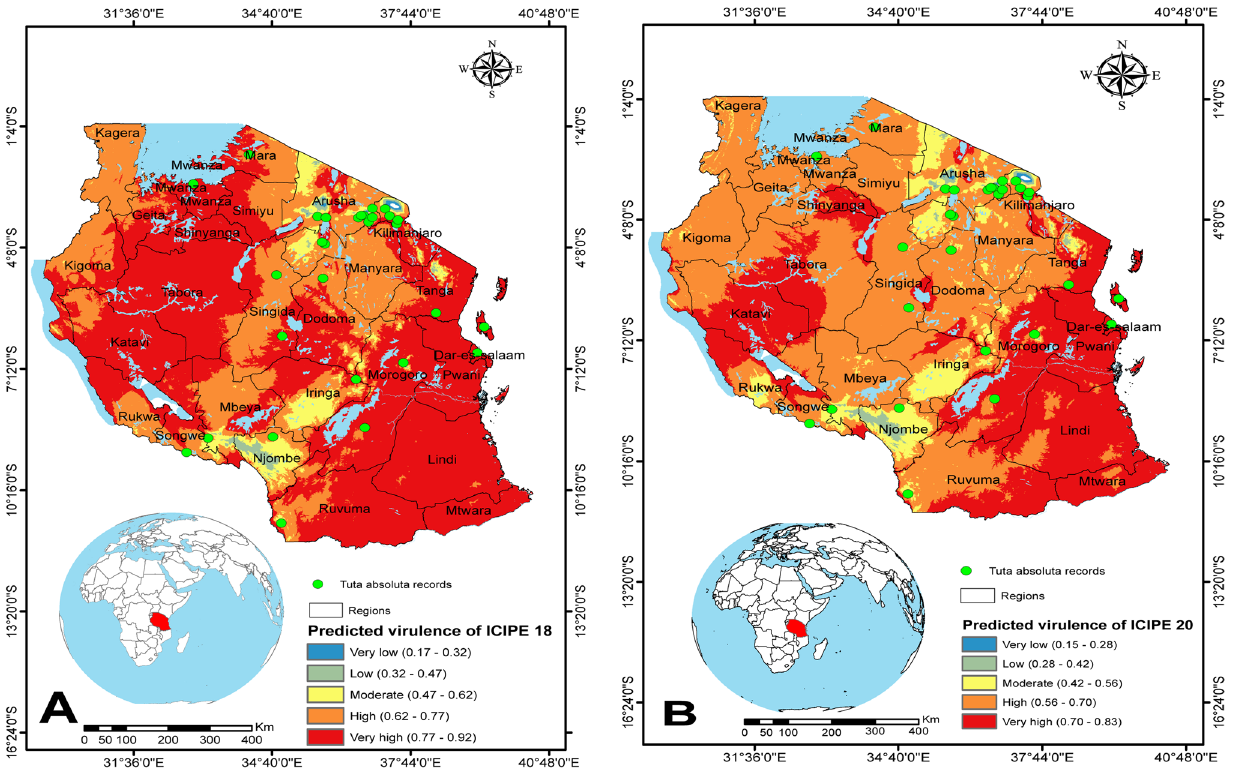
Figure 8. Spatial patterns of predicted virulence of Metarhizium anisopliae isolates ICIPE 18 and ICIPE 20 against adult Tuta absoluta in Tanzania: (A) ICIPE 18 and (B) ICIPE 20. The dots in green indicate Tuta absoluta records in the three countries. The figures were generated using the QGIS 3.10.2 software (https:// qgis. org/ downl oads/ 33 for fungal isolates of tropical origin, growth does not occur below a lower thermal threshold (10 °C) and gradually the growth increases with increase in temperature to a maximum at optimal temperature (25–28 °C), and finally decreases rapidly to zero at an upper threshold (32–35 °C) which is considered as the lethal temperature 42,43 . Although the germination and fungal growth rate reached their optimum at 30 °C for isolates ICIPE 18 and ICIPE 20, we observed a significant decrease in spore production at the same temperature. Nevertheless, isolates ICIPE 18 and ICIPE 20 yielded the highest conidia production at all the temperature regimes compared to ICIPE 665 with an optimum at 25 °C. The poor yield of conidia observed at 33 and 35 °C illustrates the requirement/impor- tance of optimum temperature to sustain conidia production and consequently boost fungal mass-production. This finding is consistent with the observation that optimum temperature for spore production is at 25°C 44 . Adults T. absoluta exposed to dry conidia showed a sharp increase in mortality at temperatures between 10 and 30 °C. The highest level of infection was observed at 25 and 30 °C for all the three fungal isolates, presumably representing the optimum temperatures at which fungal infection is most affecting the insect. This virulence pattern observed is therefore important in the selection of key application zones of these fungal candidates since their virulence is showed to be temperature-dependent. The effect of temperature on virulence of M. anisopliae dry conidia against adult stages of insect pests has previously been reported by Onsongo et al. 27 in adult Teph- ritid fruit flies Zeugodacus cucurbitae (Coquillet) (Diptera: Tephritidae) which succumbed to fungal infection over a wide temperature range (15–30 °C), with an optimum of 25 °C. A similar mortality pattern was observed with M . anisopliae isolate ICIPE 69 which was found effective against adult legume pod borer Maruca vitrata Fabricius (Lepidoptera: Crambidae) at temperature ranging from 15 to 33 °C, with an optimal temperature infec- tion ranging between 25–30°C 26 . The lowest LT 50 values were recorded at 25 and 30 °C for the most two virulent isolates, ICIPE 18 and ICIPE 20. The rapid germination and growth of these two fungal isolates at almost all the temperature range could probably explain the fastest death they induced to the insects observed in this study. This confirms the observation that fungal isolates tend to kill most rapidly at the optimum temperature of their veg- etative growth 26 . These two candidate isolates could therefore be deployed in the field with different temperature variation (20–30 °C) using an autodissemination device against adult T. absoluta through an “attract-and-infect” strategy, as they were found to be compatible with the commercial Tuta pheromone lure (TUA-Optima®) 18 . Mathematical models have become an important tool for understanding and predicting the virulence and suitable application areas of entomopathogenic fungi against insect pests of economic importance often occurring in unpredictable environmental conditions 31,45 . Here, we used T. absoluta occurrence in East Africa 4 to model the virulence of the candidate isolates (ICIPE 18 and ICIPE 20) against the pest. The decision-support tool revealed that in some areas across Kenya, Tanzania and Uganda (where the potent fungal-based biopesticides are planned